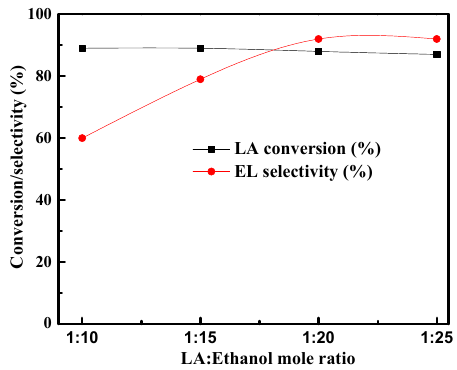
Figure 6. Mole ratio (LA to ethanol) effect using Pt/STA-ZrO 2 catalyst. Reaction conditions: temperature-240 ◦ C, feed flow-0.5 mL/h, and N 2 flow-30 mL/h.